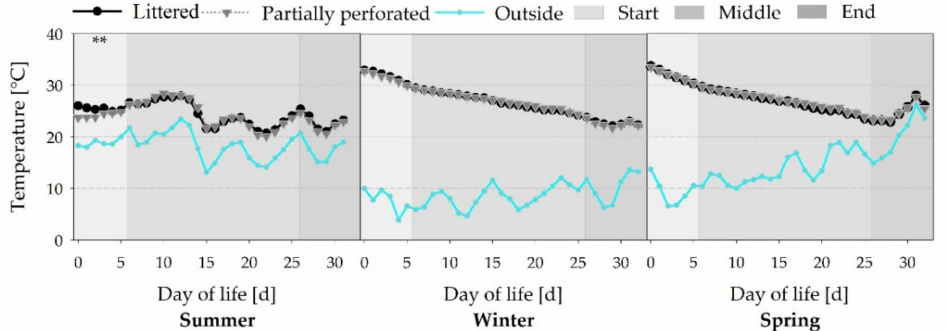
Figure 4. Average daily air temperature inside the broiler houses with two different floor types, and the outside environment air temperature measured over three different fattening periods ( n = 144 values per day and barn). Significant differences between both floor types within the three different sections (start, middle, end of the fattening period) are marked by asterisks: ** p <